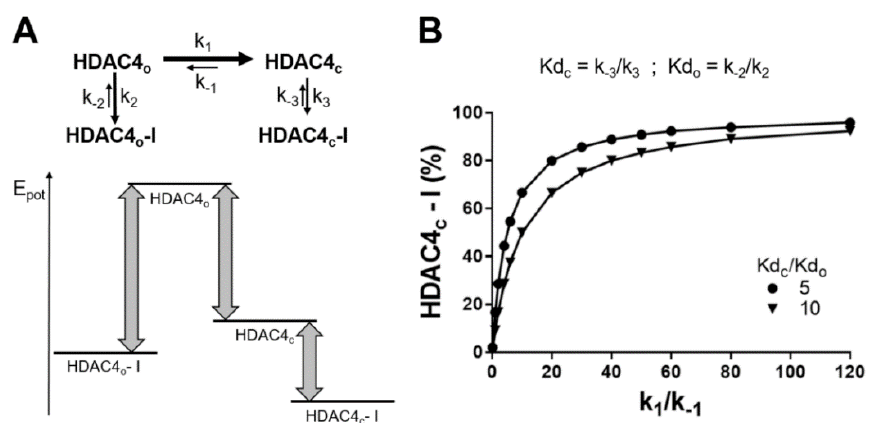
Figure 8. Energy diagram and simplified binding mechanism of open and closed form of cdHDAC4 wt . ( A ) The upper panel shows a simplified binding mechanism of a ligand, I, to the open (HDAC4 o ) and closed (HDAC4 c ) conformation of HDAC4 yielding the corresponding reversible complexes HDAC4 o -I and HDAC4 c -I. The binding equilibria are coupled to the conformational equilibrium between HDAC4 o and HDAC4 c . The k-parameters denote the respective reaction rate. The lower panel shows the corresponding energy diagram, which is consistent with the conformational equilibrium shifted toward HDAC4c and larger binding energy for the HDAC4 o -I complex than for HDAC4 c -I. ( B ) Simulation of percentage HDAC4 c -I as a function of the ratio of HDAC4 c to HDAC4 o in terms of k 1 /k -1 . Two cases are simulated: Ligand I has 5-times (filled circle) or 10-times (down-triangle) higher affinity for HDAC4 o than for HDAC4 c .